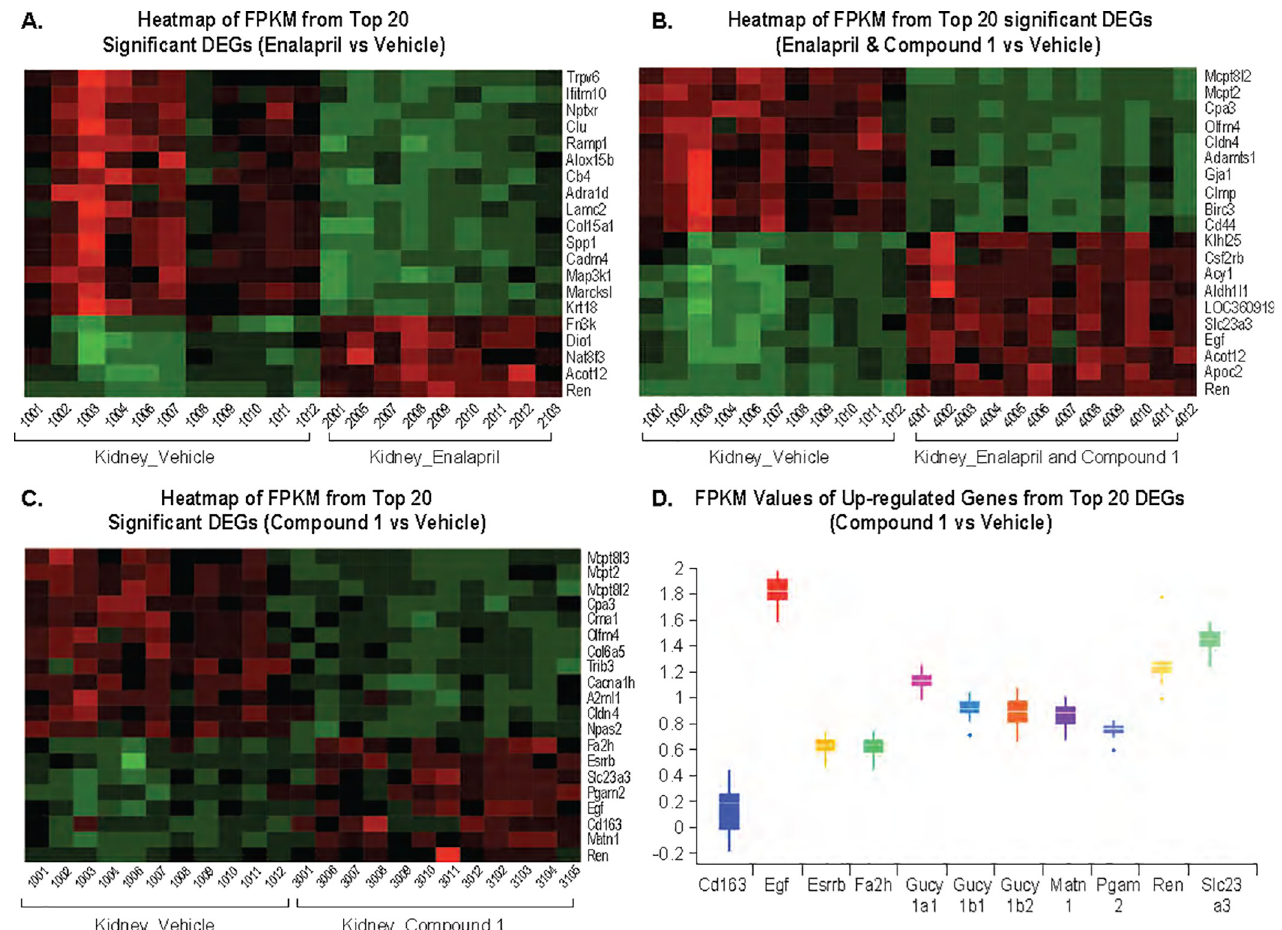
Fig 9. Significant differentially expressed genes. (A) Heatmap of most significant 20 genes from Enalapril vs Vehicle. (B) Heatmap of most significant 20 genes from Enalapril and Compound 1 vs Vehicle. (C) Heatmap of most significant 20 genes from Compound 1 vs Vehicle. (D) Upregulated genes from most significant 20 genes from Compound 1 vs